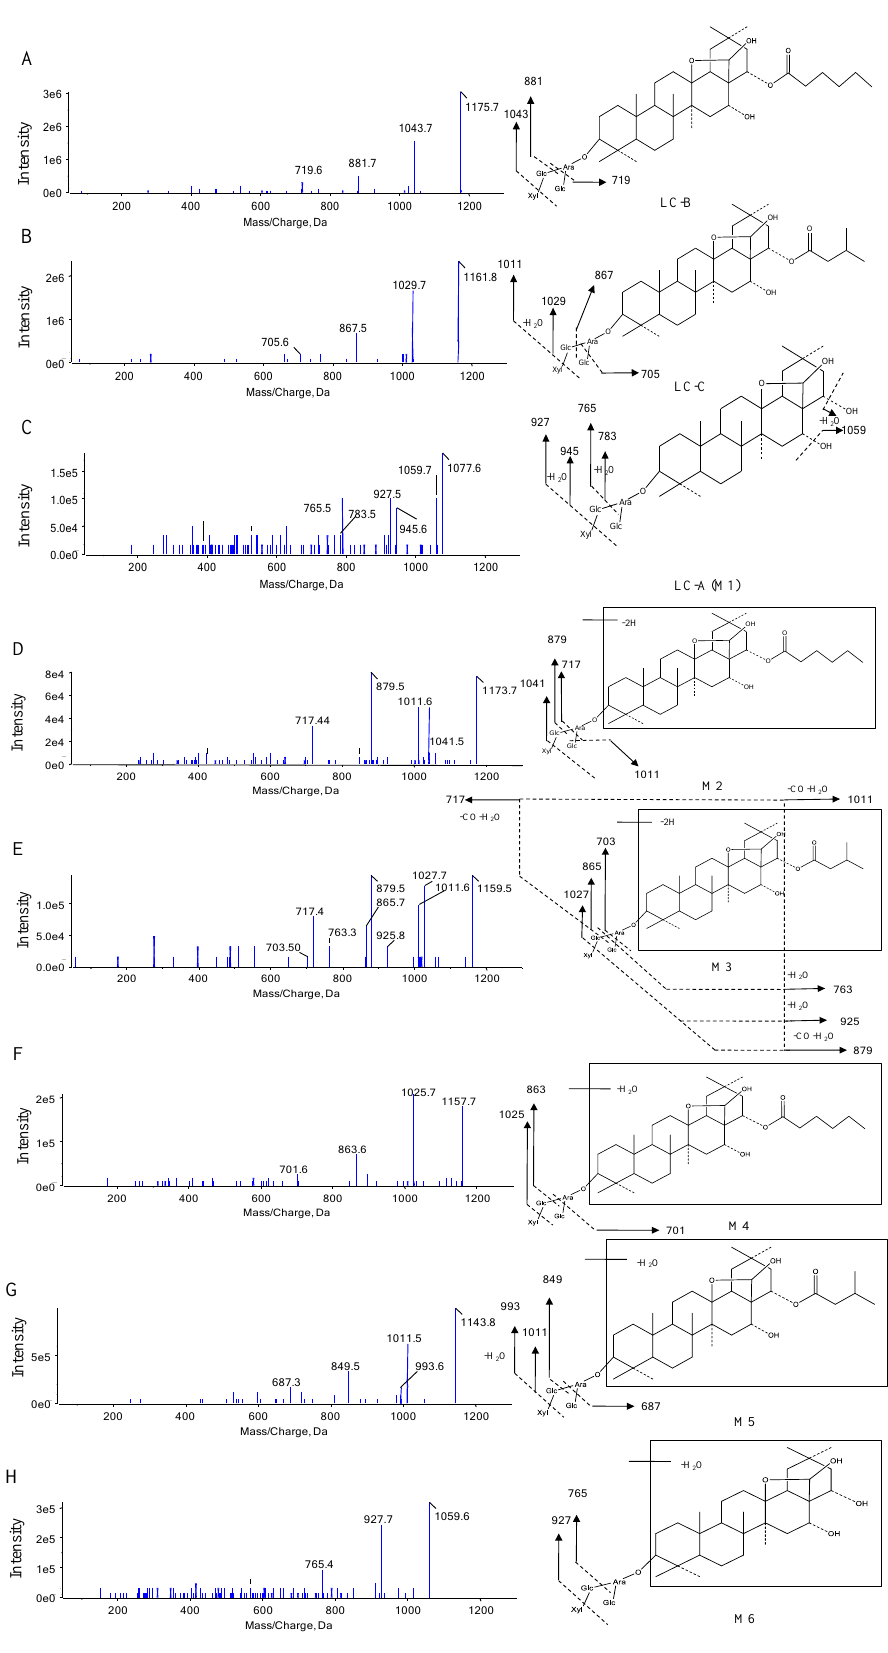
Figure 3. Typical MS/MS spectra of LC-B ( A ), LC-C ( B ), LC-A ( C ), M2-M6 ( D – H ), respectively.